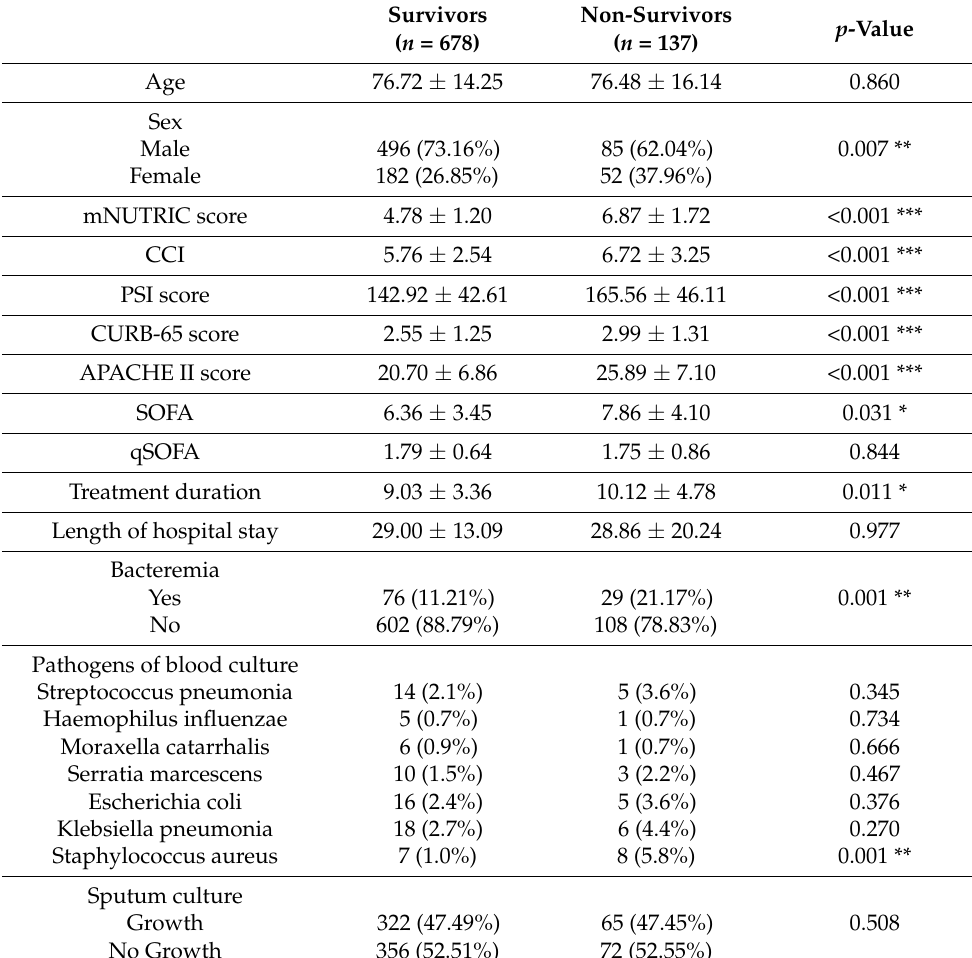
Table 2. Characteristics of clinical prediction rules and clinical factors for predicting hospital mortality in patients with